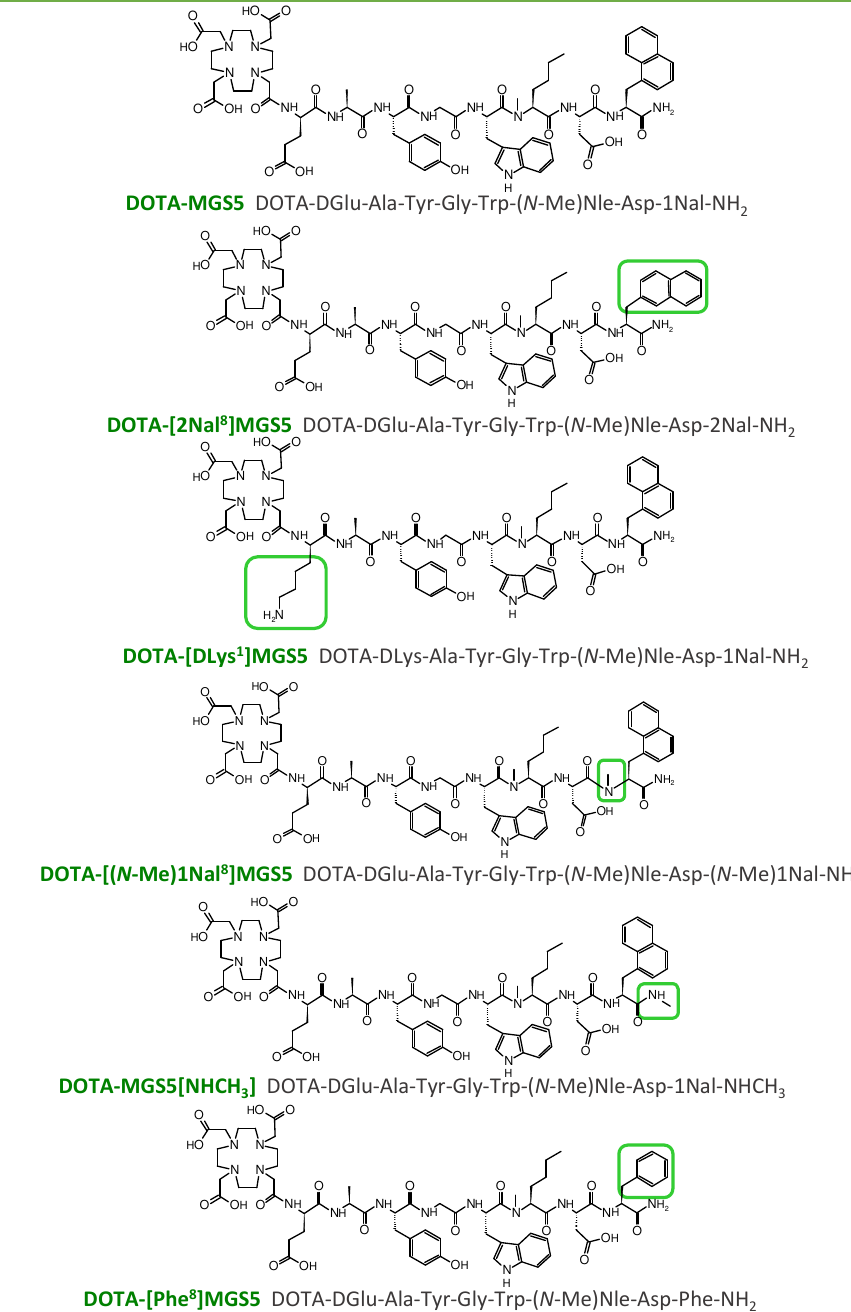
Figure 1. Structural formulas and amino acid sequences of DOTA-MGS5 and the five investigated peptide analogs.